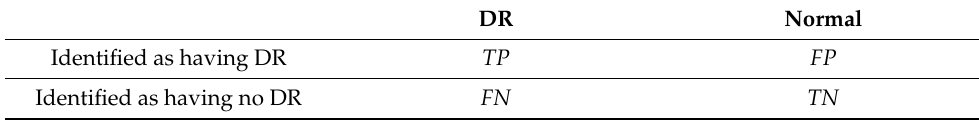
Table 8. Diagnostic test for the prevalence of the disease. DR Normal Identified as having DR TP FP FN TN